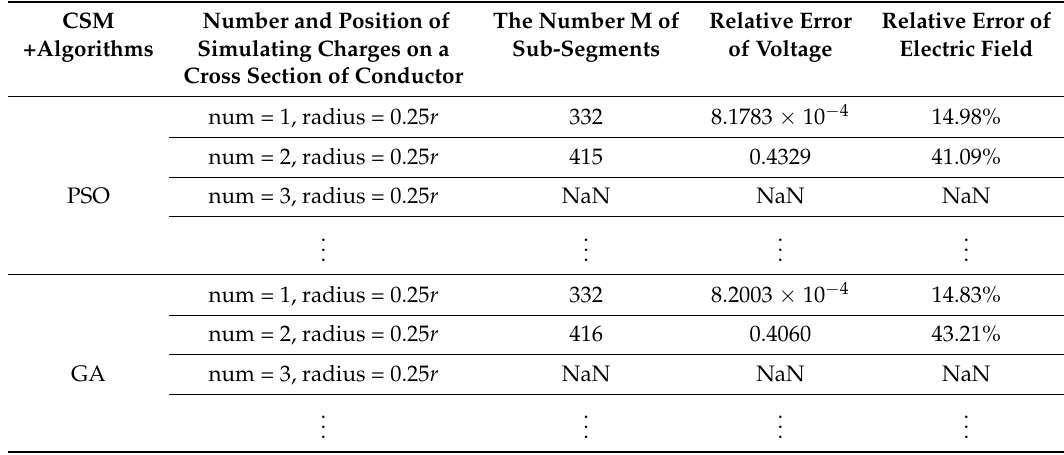
Table 3. Optimized results of PSO and GA.